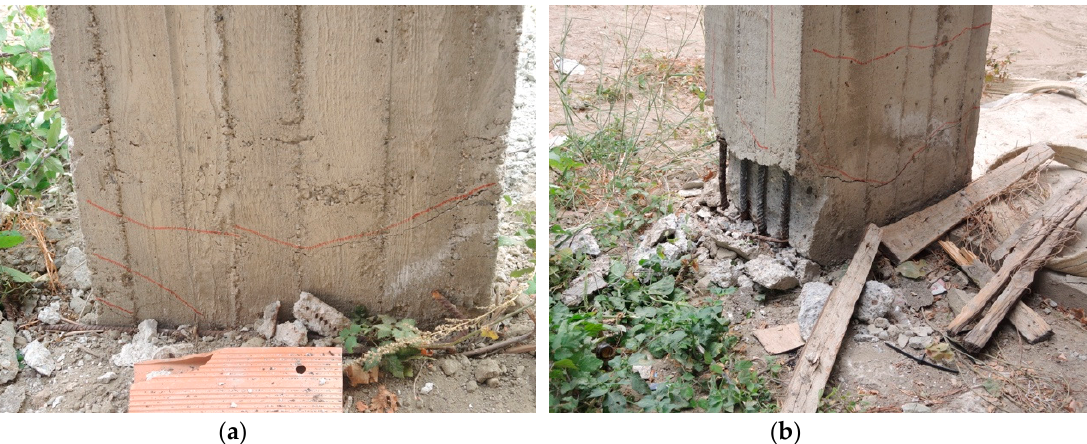
Figure 19. Run #9, 62.4 mm—1.69%: Flexural cracking pattern and failures at the base of columns c4 ( a ) and c18 ( b ).